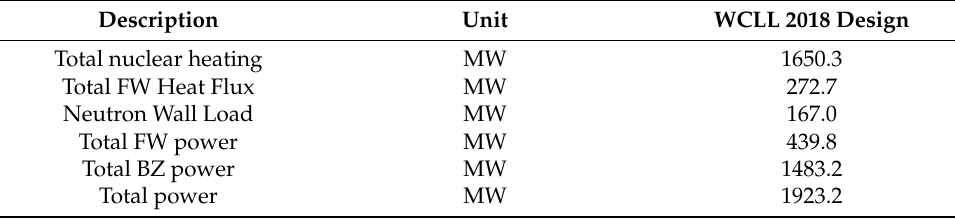
Table 2. DEMO and WCLL DCD BOP BB power balance